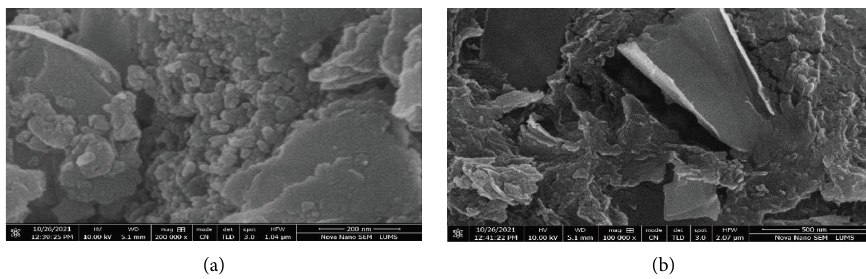
Figure 5: SEM images of cellulose/MoS